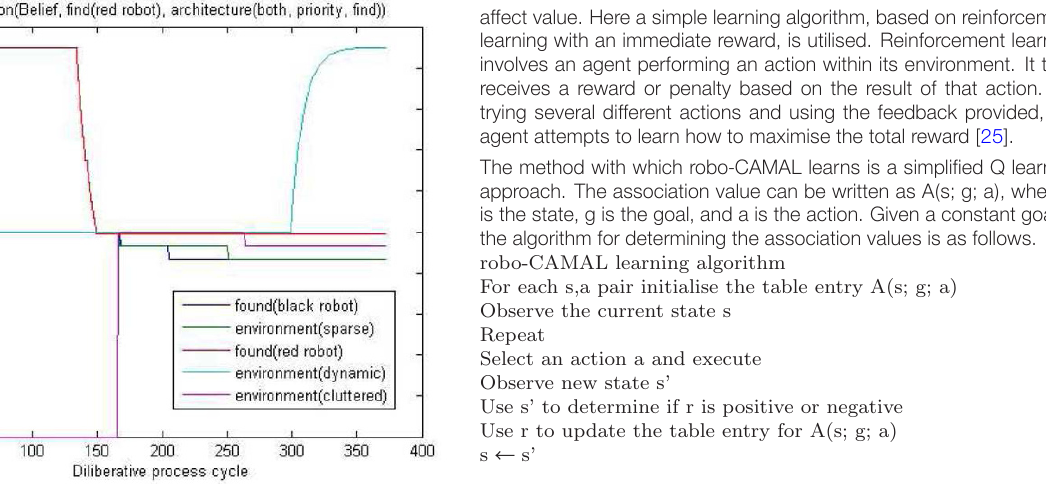
Figure 4. Association generation process for the find(redrobot)